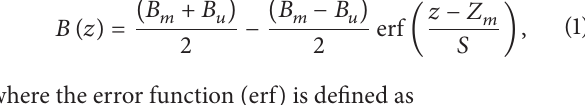
Table 1: The days selected for retrieving PBLH and for correlation analysis between PBLH and atmospheric variables from June 2007 to May 2008.